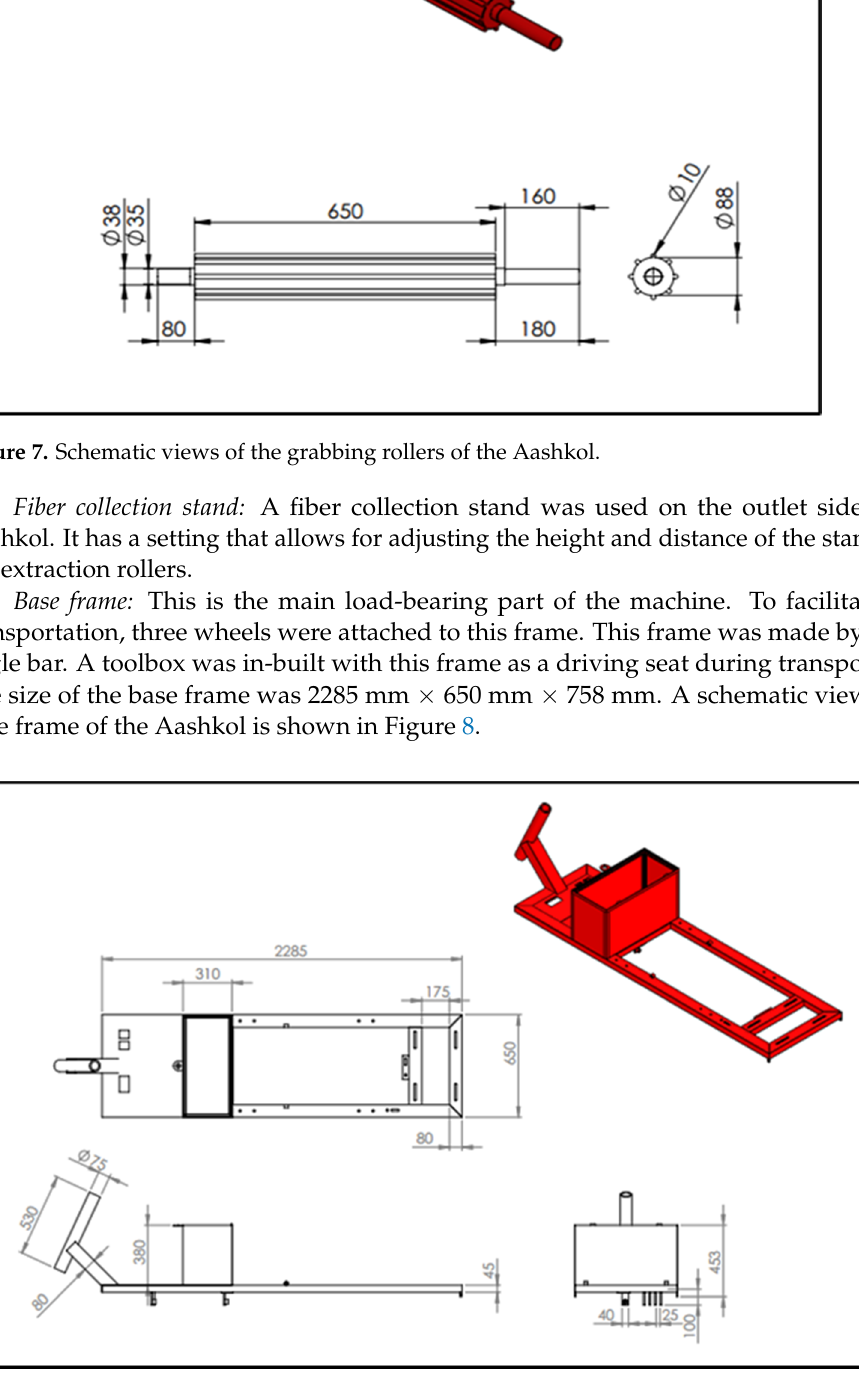
Figure 8. Schematic view of the base frame of Aashkol.